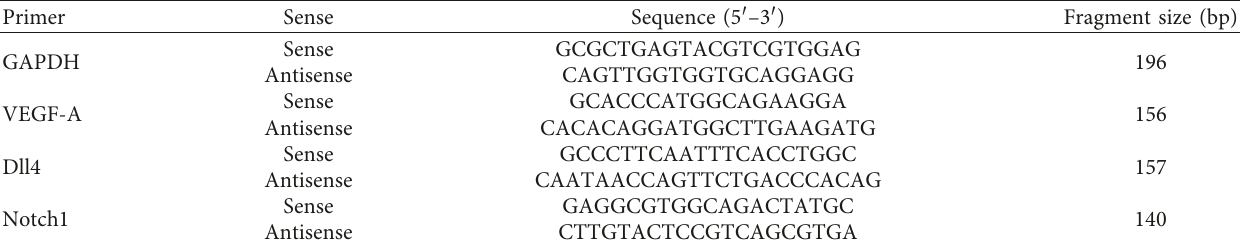
Table 1: Primers for